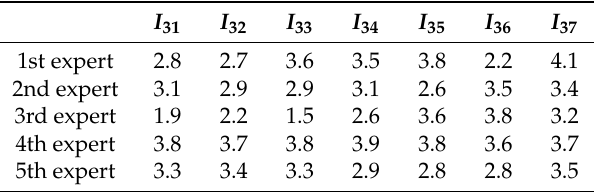
Table A19. Scores of environmental management maturity in the executing process index.